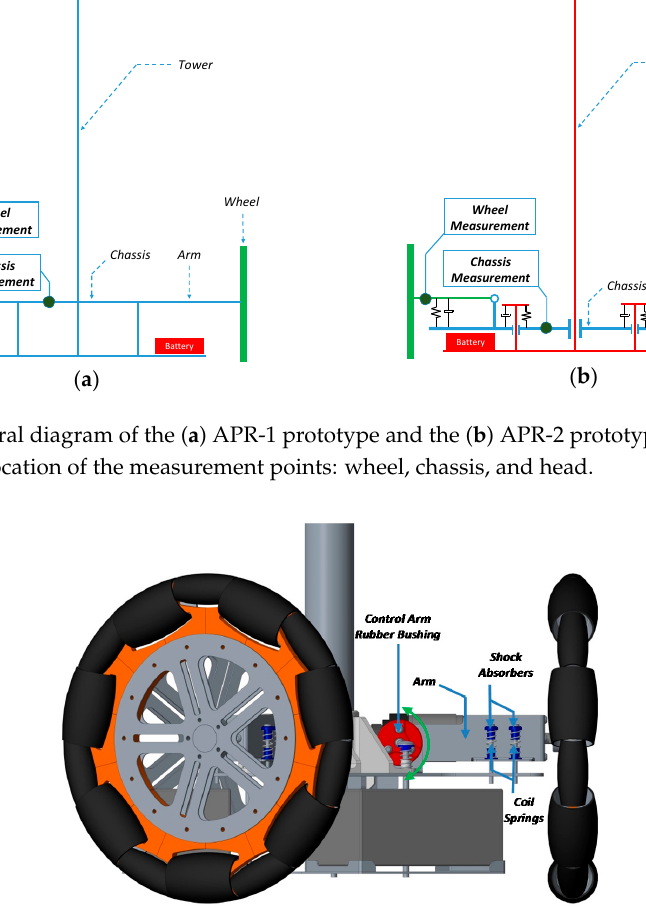
Figure 4. CAD design of the passive suspension system of the APR-2.